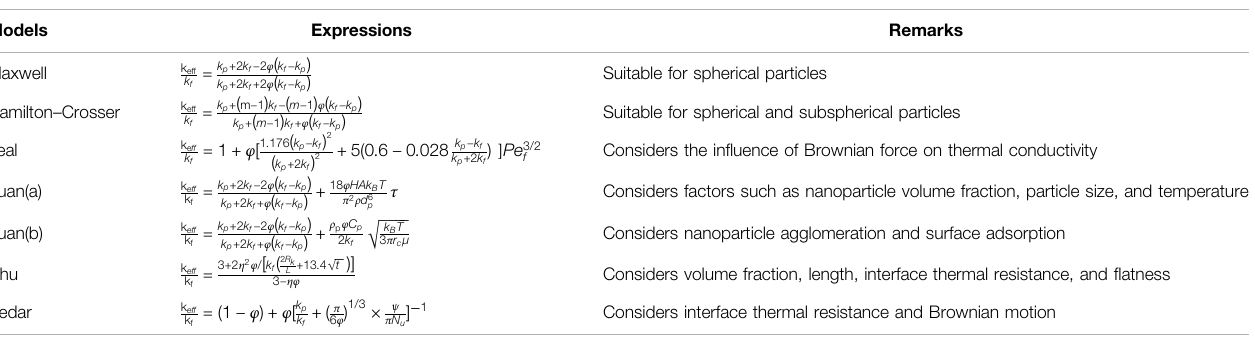
TABLE 2 | Thermal conductivity calculation models for nano fl uids.